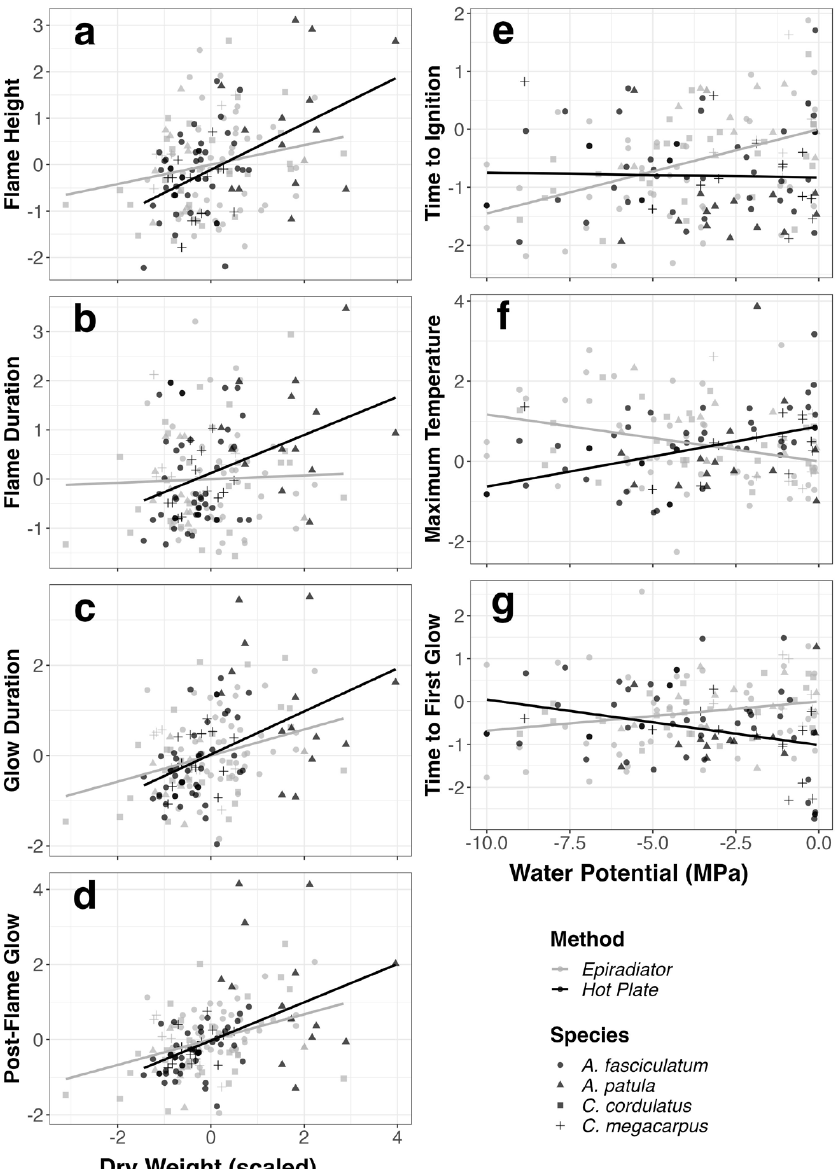
Figure 3. Flammability metrics and their best predictors (scaled dry weight ( a – d ) or water potential ( e – g )) across species. Remef was used to remove partial effects of covariates, the random effect of individual, and secondary predictors (in certain cases) from the best-performing models to isolate the effects of the primary predictor and the flammability chamber method (epiradiator, gray; and hot plate, black) .